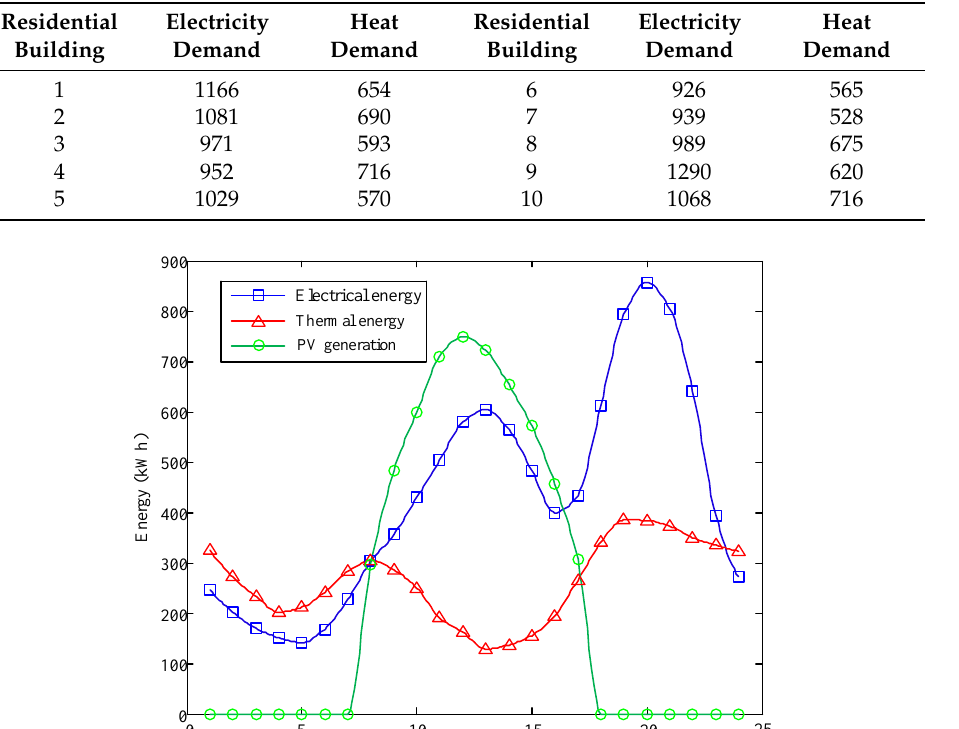
Table 1. Daily energy demand of each prosumer (kWh).